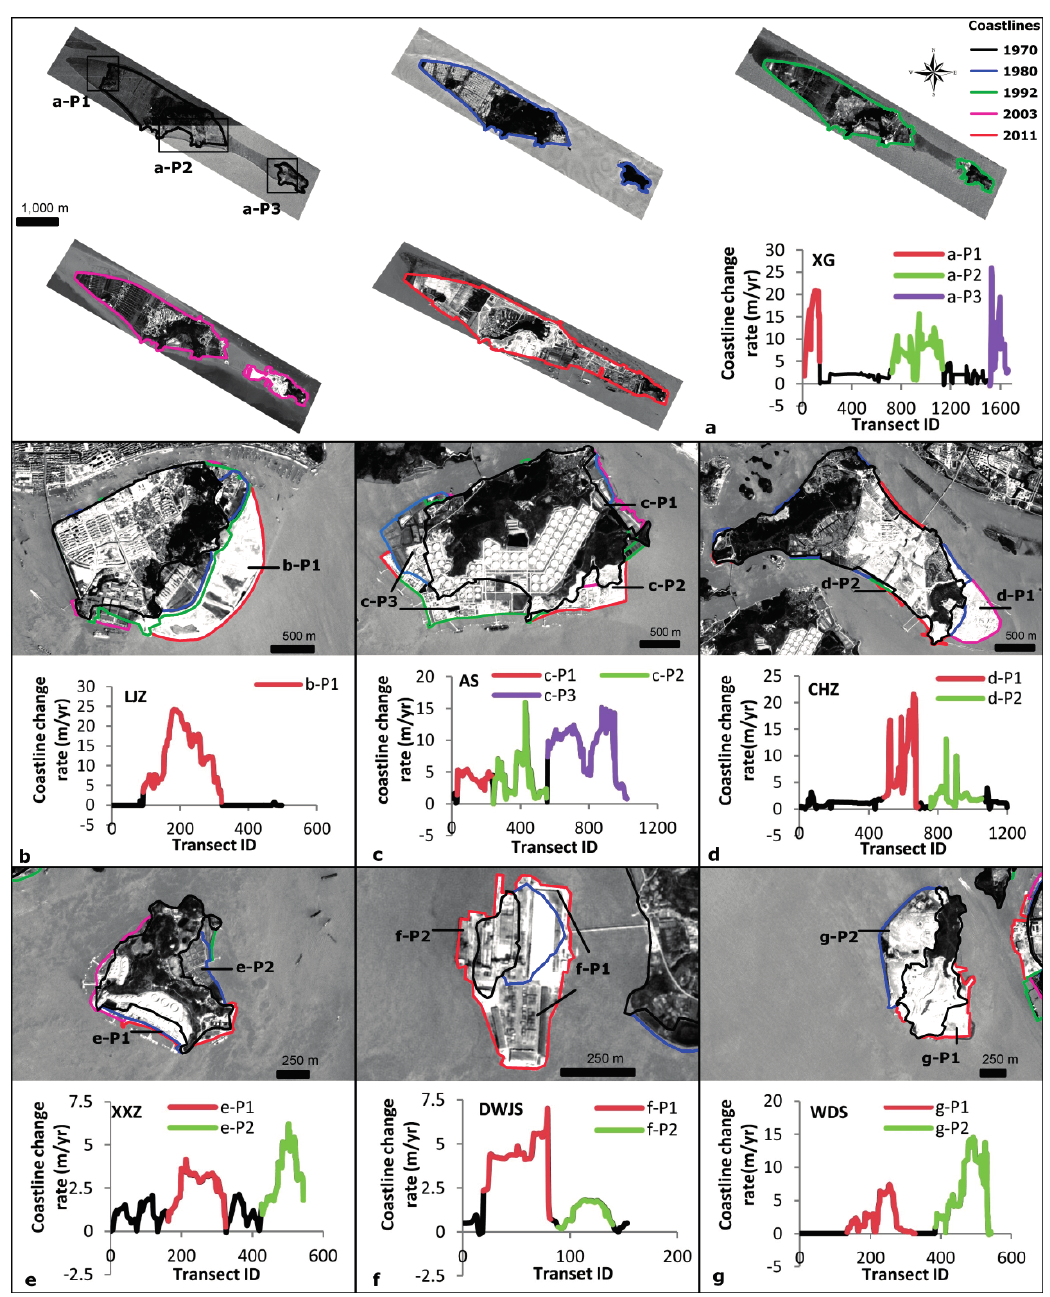
Figure 5. Coastline change rates along different transects during 1970–2011, for ( a ) Xiaogan-Mazhi Island (XG); ( b ) Lujiazhi Island (LJZ); ( c ) Aoshan Island (AS); ( d ) Changzhi Island (CHZ); ( e ) Xixiezhi Island (XXZ); ( f ) Dawangjiaoshan Island (DWJS), and ( g ) Waidiaoshan Island